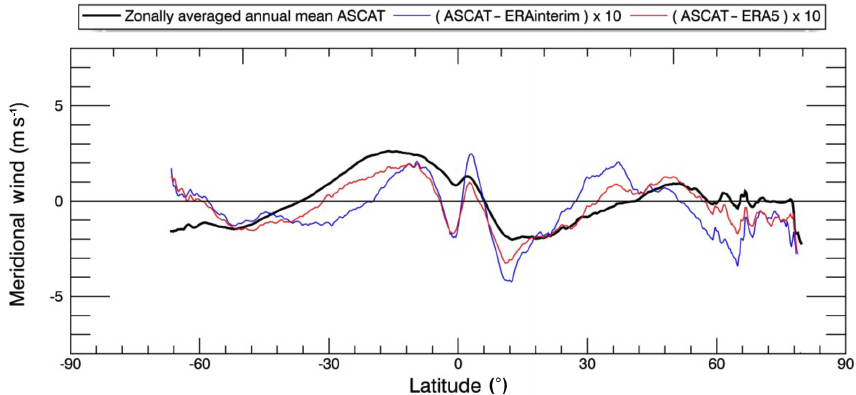
Figure 4. Zonally averaged annual mean meridional wind from ASCAT (thick black line) and differences with ERA-Interim (blue line) and ERA5 (red line) first-guess winds over 2016. Note that differences have been scaled by